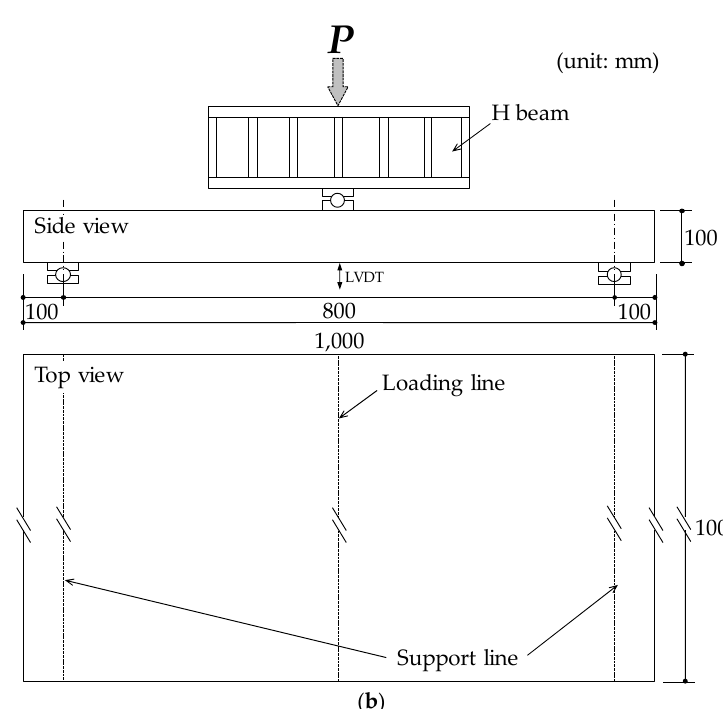
Figure 3. Test setup for SFRC pedestrian deck: ( a ) picture, ( b ) schematic description.